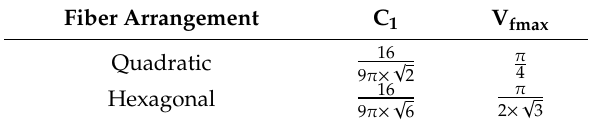
Table 3. Gebart model: constant values for quadratic and hexagonal fiber arrangement. Fiber